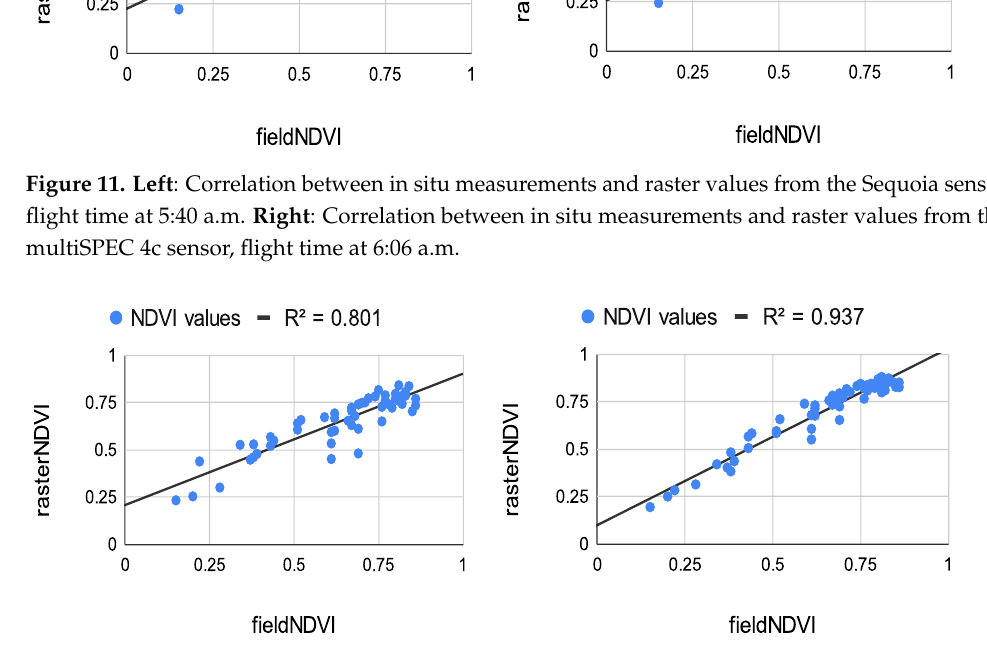
Figure 12. Left : Correlation between in situ measurements and raster values from the Sequoia sensor, flight time at 2:01 p.m. Right : Correlation between in situ values and raster values from the multiSPEC 4c sensor, flight time at 1:45 p.m.